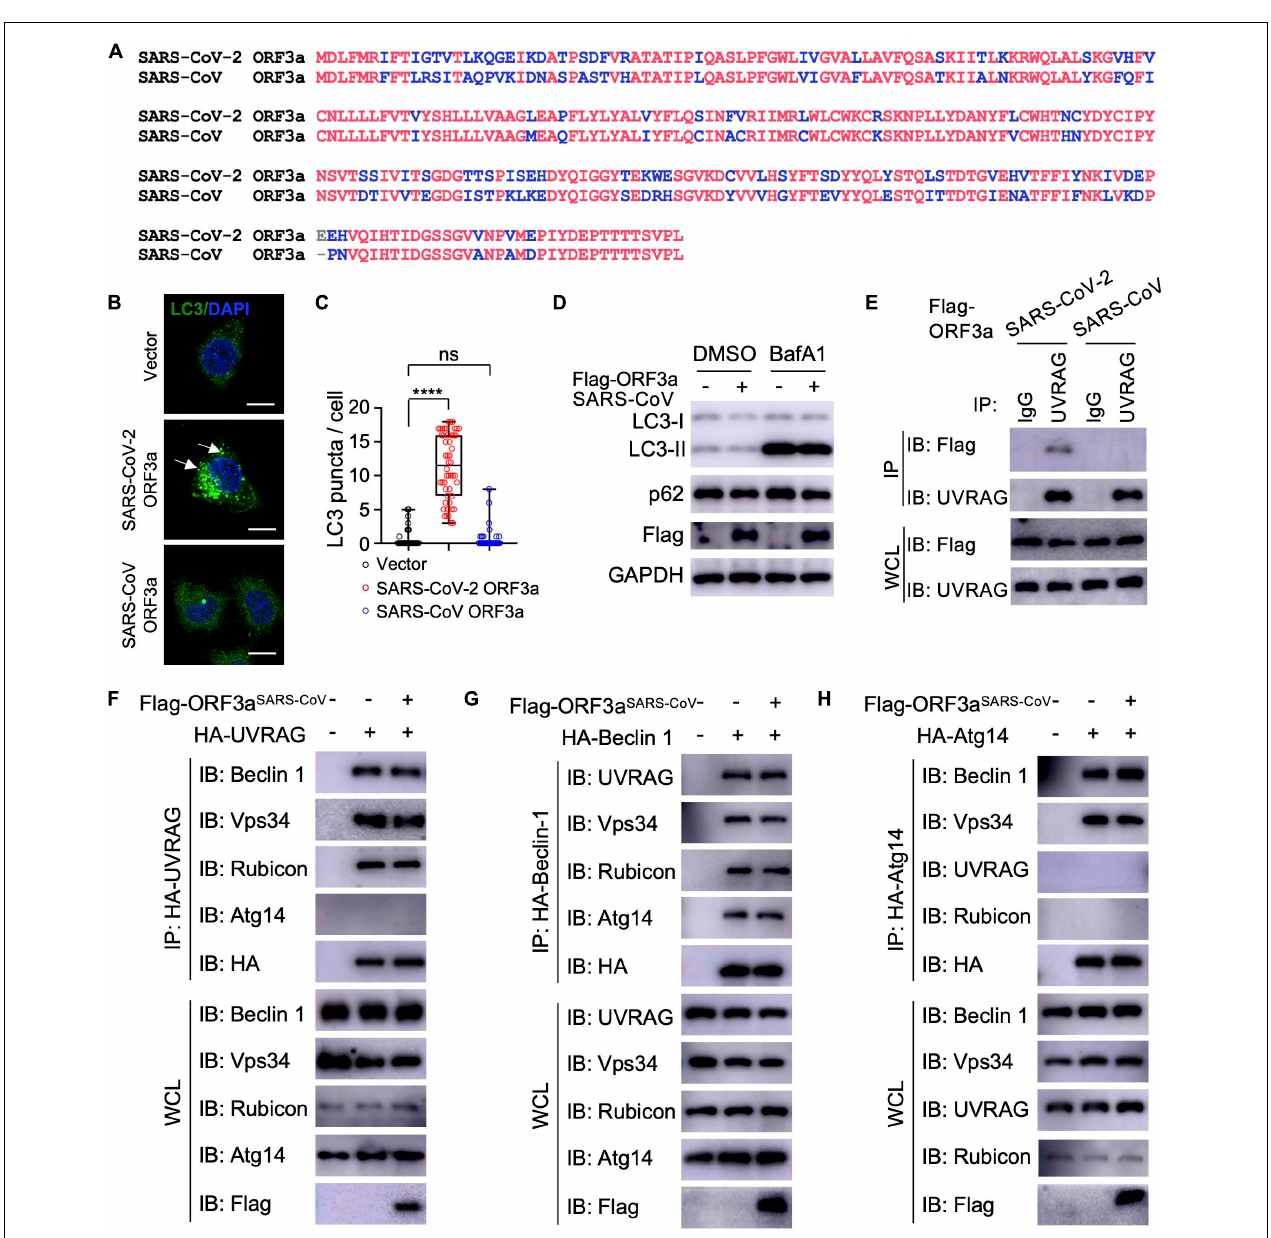
FIGURE 4 | SARS-CoV ORF3a cannot induce autophagy. (A) Sequence alignment between SARS-CoV-2 ORF3a and SARS-CoV ORF3a. (B–D) SARS-CoV ORF3a does not affect autophagy. HeLa-vector, HeLa-ORF3a SARS - CoV - 2 , or HeLa-ORF3a SARS - CoV cell lines were treated with BafA1 (100 nM) and endogenous LC3 puncta were immunostained (B) and quantified (C) . Scale bar, 15 µ m. Arrow: representative autophagosomes. Mean ± SEM; n = 50; ns and **** p < 0.0001 by one-way ANOVA and Bonferroni’s post hoc test. HeLa-vector or HeLa-ORF3a SARS - CoV cell lines were treated with BafA1 (100 nM) for 4 h and the cell lysates were collected for IB with indicated antibodies (D) . (E) ORF3a SARS - CoV - 2 but not ORF3a SARS - CoV interacts with endogenous UVRAG. HEK293T cells were transfected with Flag-ORF3a SARS - CoV or Flag-ORF3a SARS - CoV - 2 and cell lysates were collected and subjected to IP and IB with indicated antibodies at 48h post-transfection.